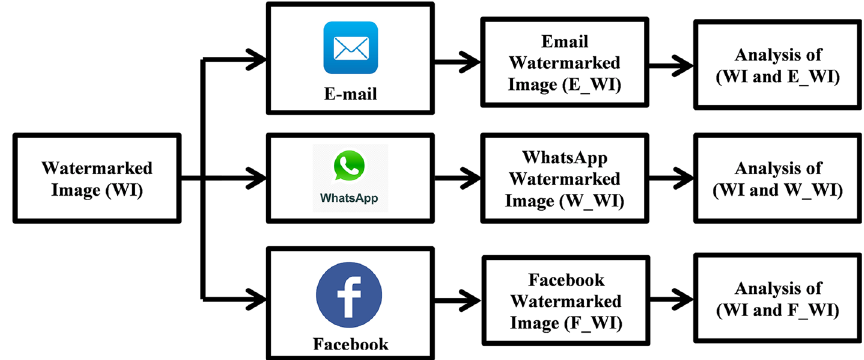
Fig. 6 Analysis of watermarked image via E-mail, WhatsApp and Facebook